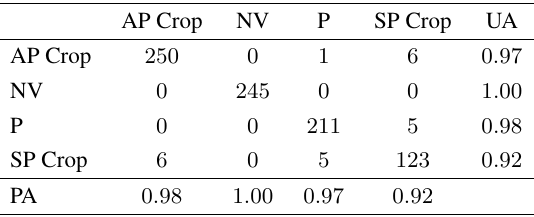
Table 3. Confusion matrix of CBERS-4 data cube obtained by 5-fold cross validation of classification of field data, and values of producer’s accuracy (PA) and user’s accuracy (UA) for each